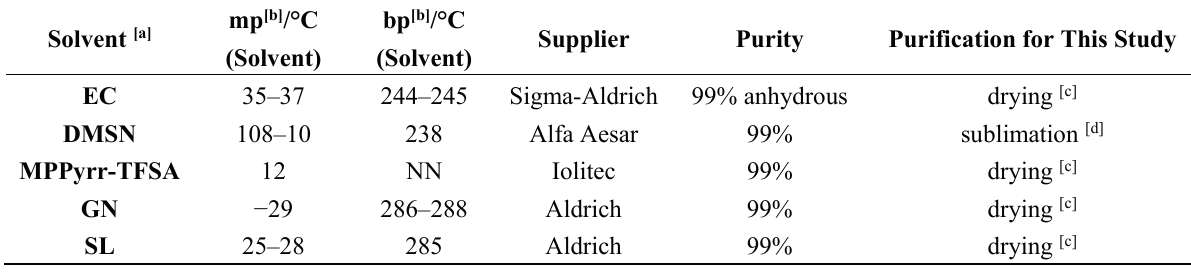
Table 5. Purity and selected properties (mp = melting point, bp = boiling point) of chemicals, which are used in the study (pure solvents, preparation of electrolyte mixtures